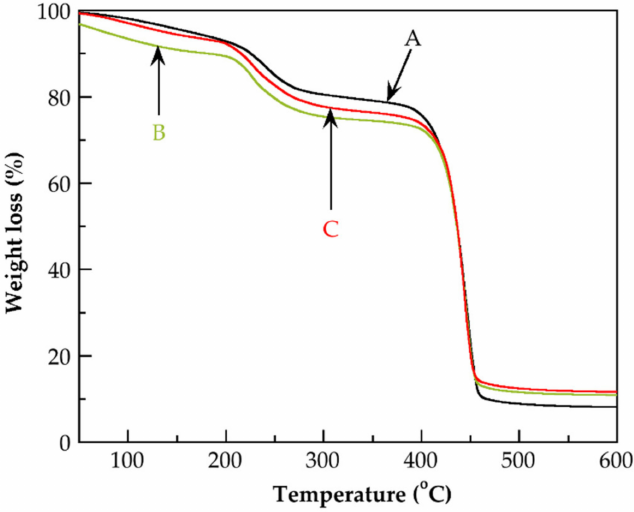
Figure 9. TG thermograms of PMAA 3 ( A ), PMAA-G 3.0 -CNTs 5 ( B ), and PMAA-G 3.0 -CNTs 6 ( C